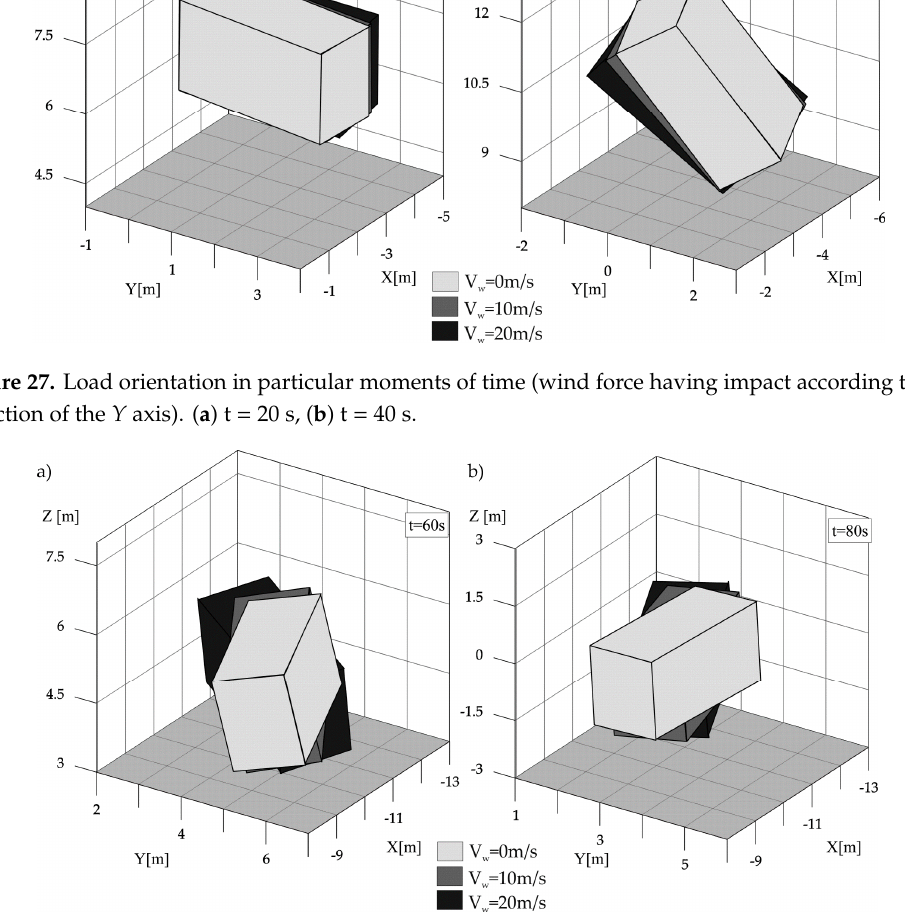
Figure 28. Load orientation in particular moments of time (wind power having impact according to the direction of the Y axis). ( a ) t = 60 s, ( b ) t = 80 s.